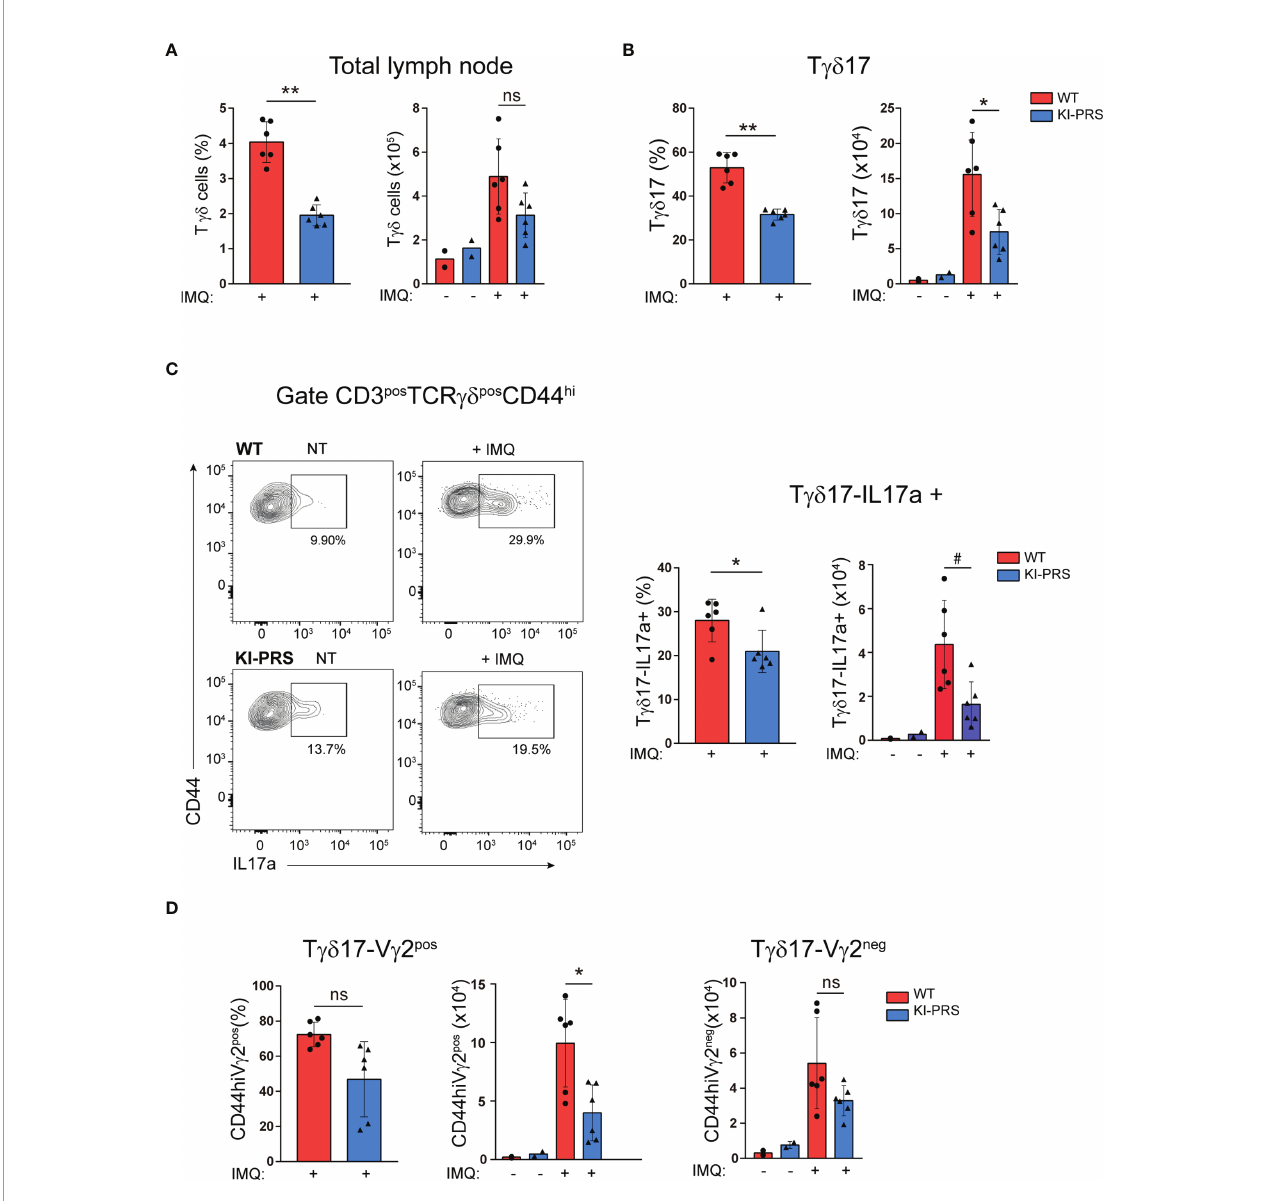
FIGURE 6 | Lymph node T gd 17 expansion upon Imiquimod-induced skin in fl ammation challenge depends on an intact CD3 e -PRS. KI-PRS and WT littermates were treated with Imiquimod (IMQ) for 7 days on ears and shaved backs, or left untreated (NT). On day 7, skin-draining lymph nodes were harvested and processed for fl ow cytometry analysis of T gd cells. (A) Graphs represent the frequency ( left , **p-value= 0.0022) and absolute cell number ( right ) of total T gd cells gated as CD3 pos TCR gd pos . (B) Graphs represent the frequency ( left , **p-value= 0.0022) and absolute cell number ( right , *p-value= 0.0411) of T gd 17 cells, gated as CD3 pos TCR gd pos CD44 hi . (C) Analysis of IL-17A production. Total lymph node cells were stimulated with PDBu/Io for 4h in presence of Golgi-Plug, and IL-17A production was determined by fl ow cytometry. Representative dot plots show IL-17A production among T gd 17 cells (gated as CD3 pos TCR gd pos CD44 hi ), and inset numbers represent the percentage of IL-17A+ cells. Graphs show the frequency ( left , *p-value= 0.0312) and absolute cell number ( right , # p-value= 0.0152) of IL- 17A-producers among T gd 17; cells. (D) Graphs represent the frequency ( left ) and absolute cell number ( right , *p-value= 0.0411) of V g 2 pos and V g 2 neg cells among T gd 17 cells, gated as CD3 pos TCR gd pos CD44 hi . All graphs represent mean ± sd of n=6 mice of each genotype. Statistical analysis was performed using Mann- Whitney t-test. ns, non signi fi cant. Data are representative of 2 independent